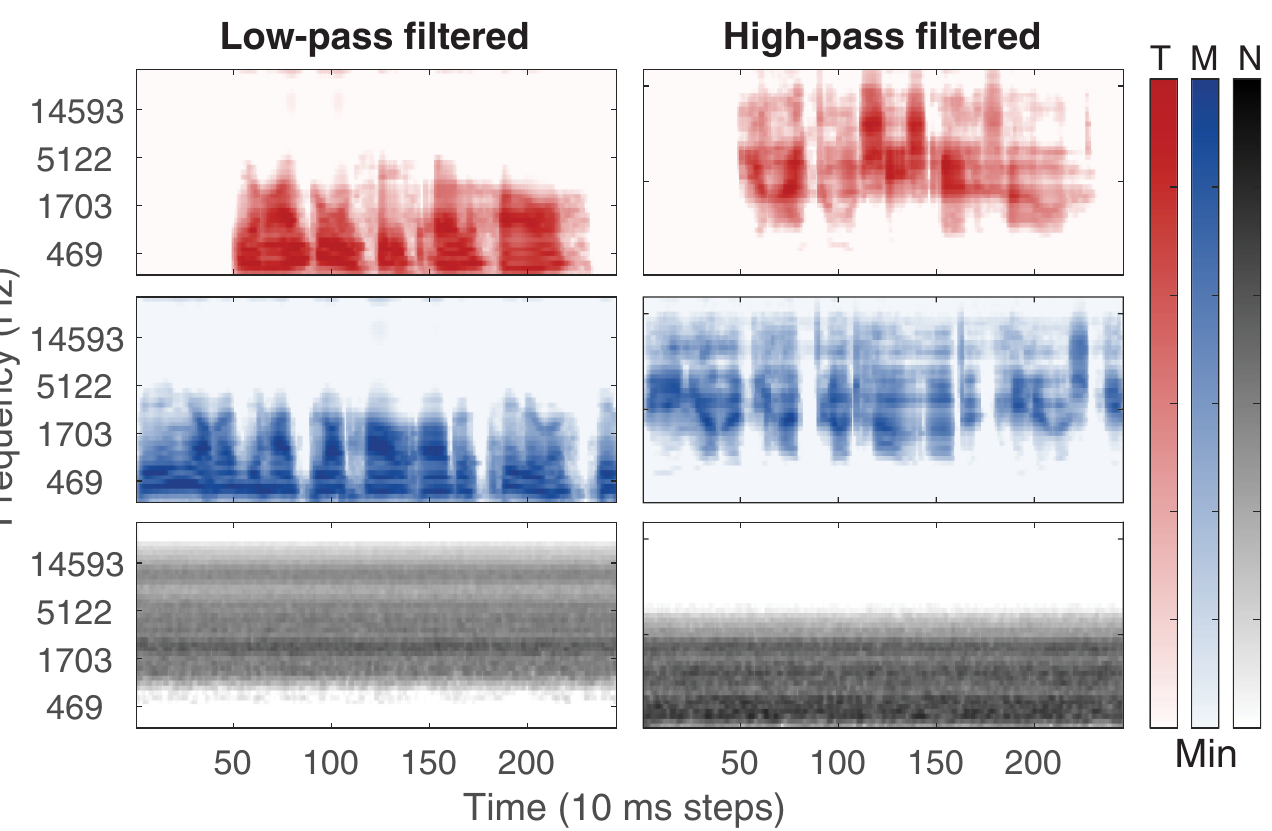
Fig 1. Lowpass and highpass filtered stimuli. Cochleagrams generated using the gammatonegram function [21] for an example of the stimuli with Δ F0 of 4 STs for the lowpass- and highpass-filtered conditions in the left and right columns, respectively. The top row shows the target (T), the middle row shows the speech masker (M) and the bottom row shows the off-band noise masker